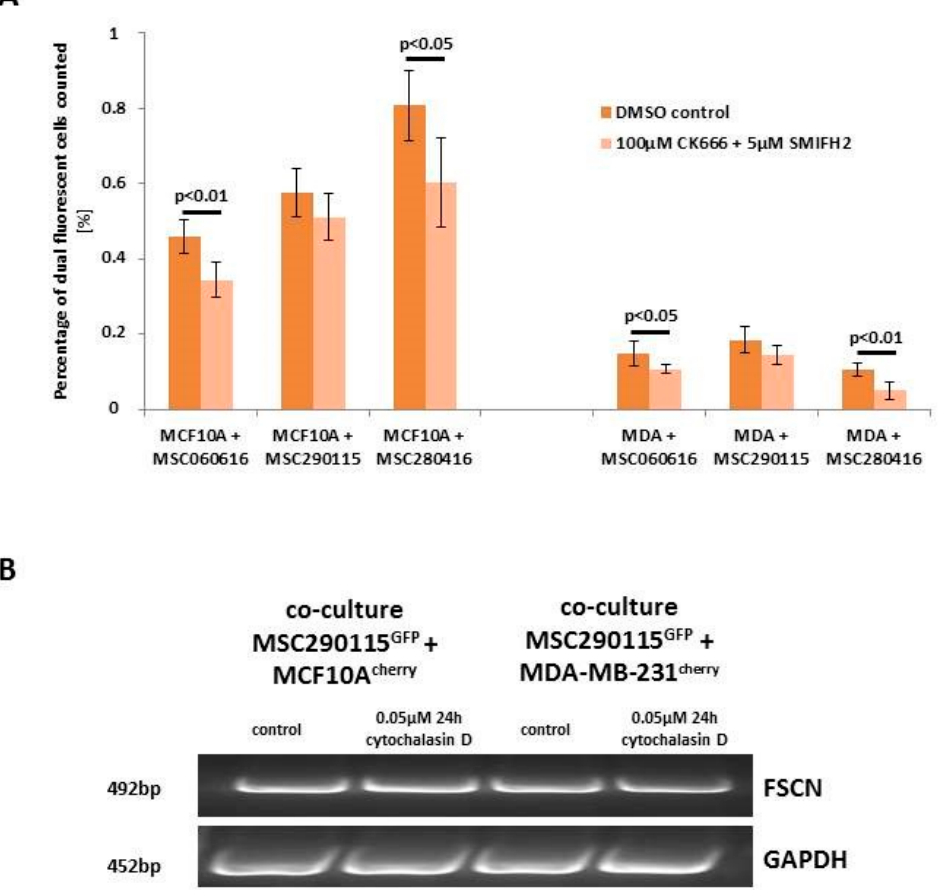
Figure 3. Quantification of hybrid cell formation during treatment with CK666 and SMIFH2, as well as PCR analysis of fascin. ( A ) Dual fluorescent cell formation was evaluated in co-cultures (MSC GFP from three different donors with breast cancer cell populations MCF10A cherry and MDA-MB-231 cherry ) after 24 h treatment with 100 µ M actin-related protein (Arp2/3) complex inhibitor CK666, and 5 µ M cell-permeable inhibitor of formin homology 2 (FH2) domains (SMIFH2). Data represent the mean ± SD ( n = 6), and significances were calculated by Student´s t -test. ( B ) Co-cultures of MSC290115 GFP with MCF10A cherry and MDA-MB-231 cherry , respectively, were stimulated for 24 h with 0.05 µ M cytochalasin D, and expression of fascin was examined by PCR analysis. Transcript levels of GAPDH served as a